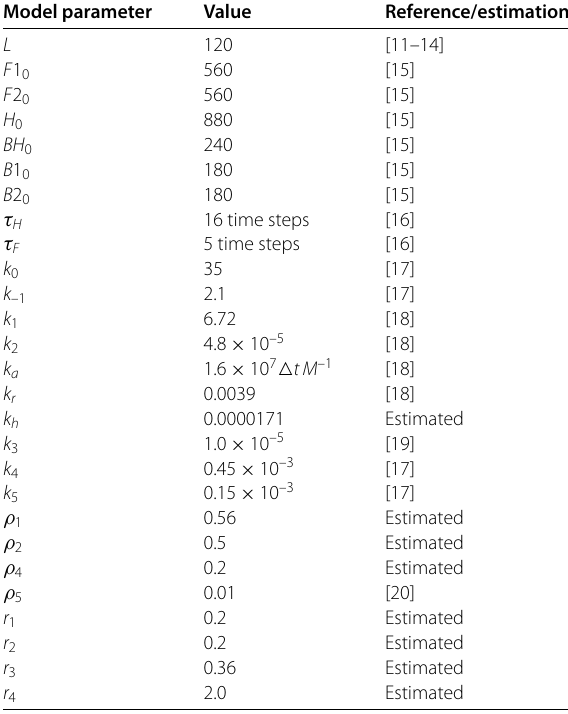
Table 3 Values of parameters in CA model Model parameter